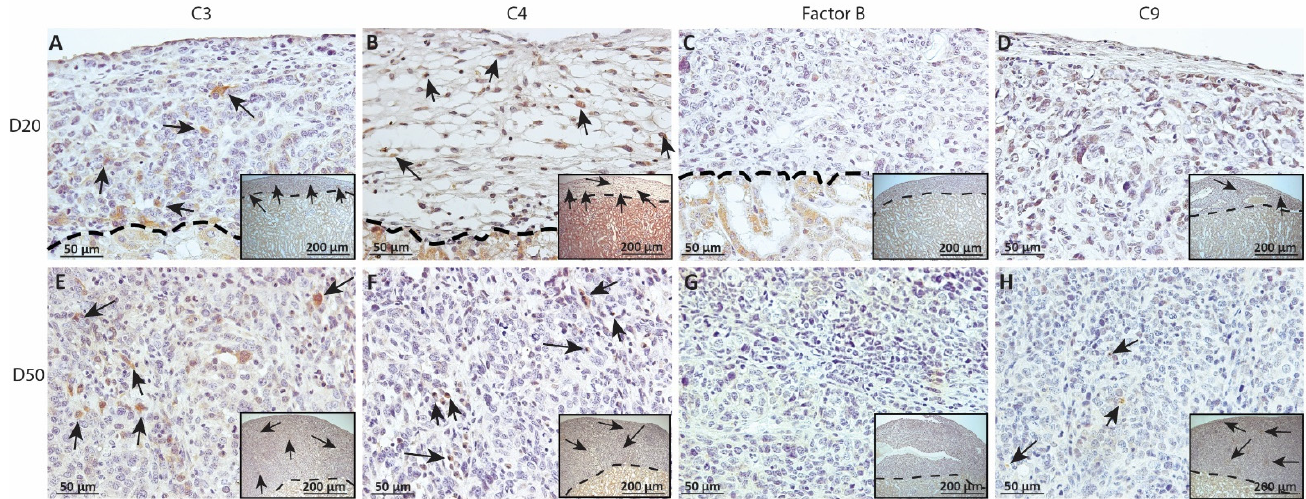
Figure 8. Immunohistochemical analysis of complement fragment deposition on MSC1-HI chronic timepoint allografts. Graft-bearing MSC1-HI kidneys were collected at days 20 ( A – D ) and 50 ( E – H ) post-transplantation and tissue sections were immunostained for C3 (brown; A , E ), C4 (brown; B , F ), FB (brown; C , G ), or MAC (brown; D , H ). Insets are lower magnification. A dotted line separates the graft from the kidney. Sections were counterstained with hematoxylin (blue). Arrows indicate examples of positive staining.